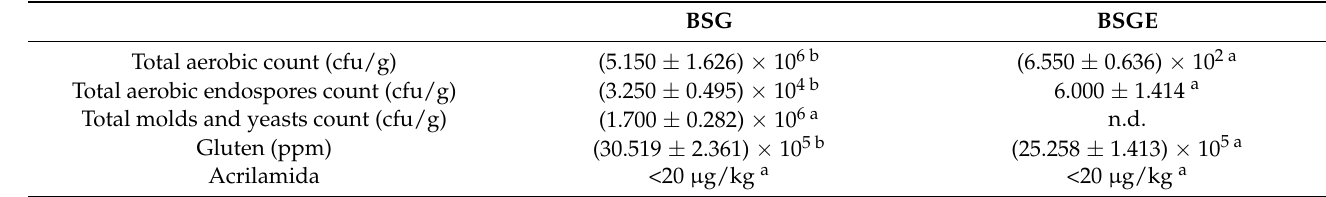
Table 8. Food security evaluation of BSG and